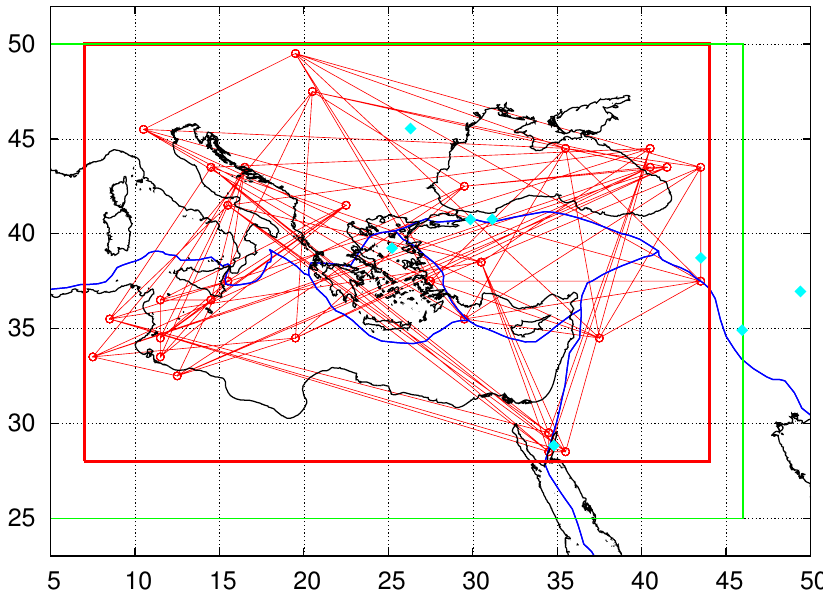
Figure 1. Map of the area N 52 E 50 together with the plate boundaries (blue) according to Bird [132]. The epicenters of the 23 5 strong EQs with M ≥ 7.1 since 1981 are shown with cyan diamonds. The EQs from top to bottom are: the 1986 M7.2